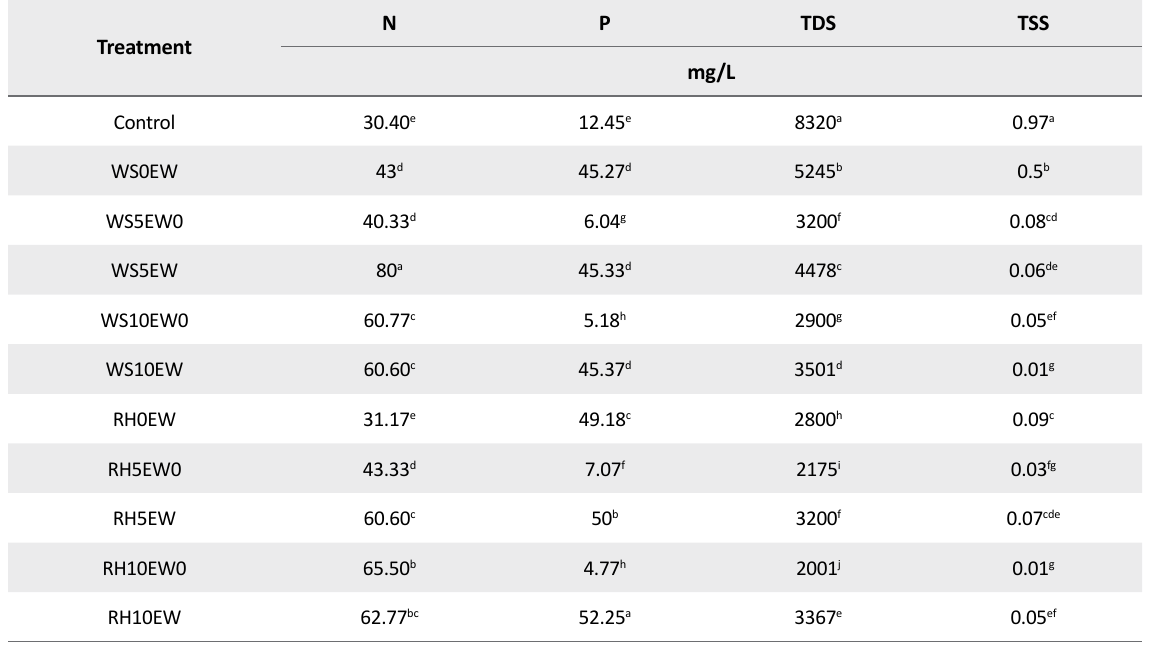
Table 3. Influence of different treatments on the status of Nitrogen (N), Phosphorous (P), Total Dissolved Solids (TDS), and Total Suspended Solids